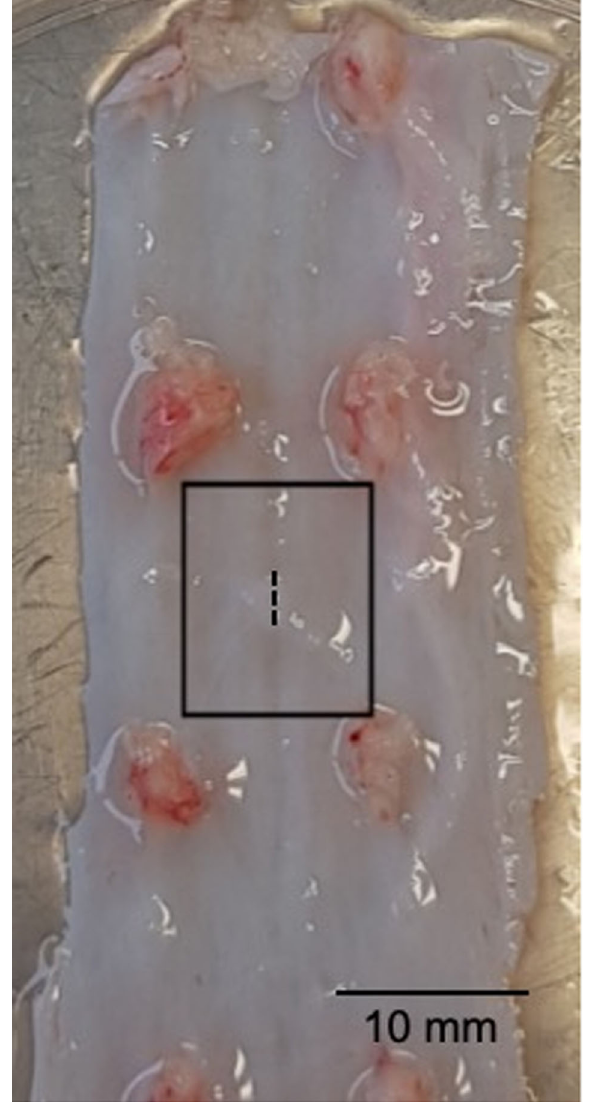
Fig. 4 Thoracic spinal dura mater. The dotted line represents the line at which the dura is cut. The outlined rectangle indicates the test dura section